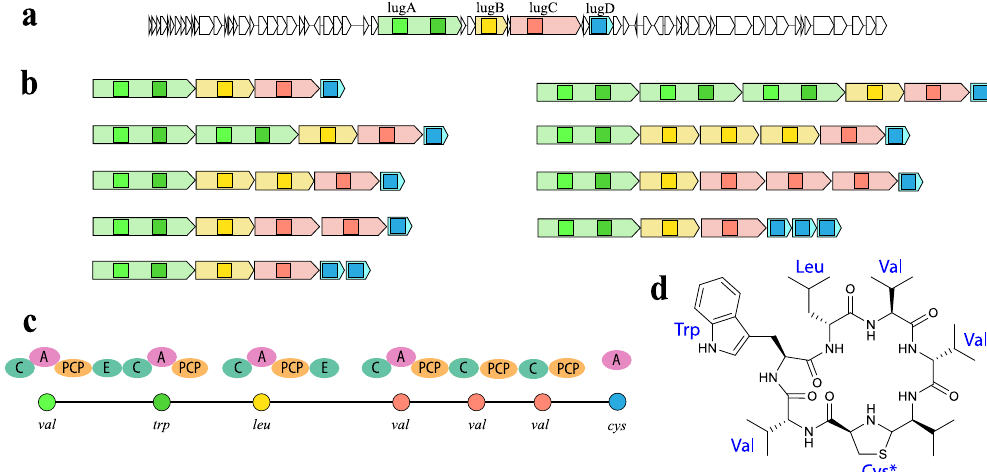
Fig. 7 Lugdunin BGC and the assembly lines formed by NRPminer using the OrfDup option. a Lugdunin BGC with the four ORFs shown in different colors. The squares represent the A-domains. b Assembly lines formed by duplication of a single NRPS subunit (corresponding to each ORF) zero, one, and two times are pictured. NRPminer explores all assembly lines generated by duplicating each ORF up to two times when the “ OrfDup ” option is selected. c The NRPS assembly lined (with A-, C-, PCP-, and E-domains pictured) appearing in the NRPS that synthesizes lugdunin, where one Val-speci fi c A-domain loads three amino acids ( valines ) to the growing peptide. Amino acids corresponding to lugdunin structure are shown below each A-domain. Circles represent amino acids (different amino acids are shown by different colors). d Cyclic structure of lugdunin with the amino acids highlighted in blue. The “ Cys* ” represent Cys-derived thiazolidine in lugdunin